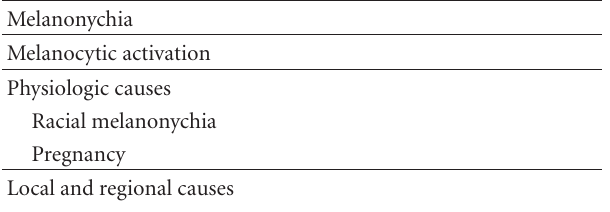
Table 2: Drugs associated with melanocytic activation and subse- quent longitudinal melanonychia. Table adapted from J. Andre, N. Lateur. Pigmented nail disorders